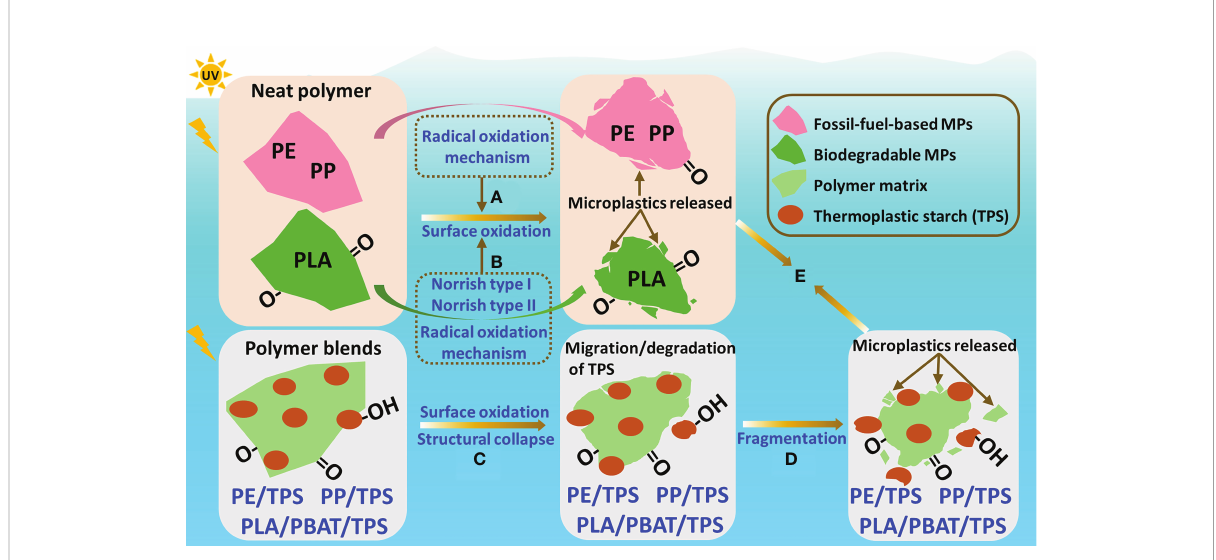
FIGURE 7 Schematic illustration of the possible photodegradation mechanisms of MPs. (A) Surface oxidation of PE and PP caused by free radical chain reactions; (B) surface oxidation of PLA caused by Norrish type I reaction, Norrish type II reaction, and radical oxidation reaction; (C) the island- sea structure of polymer blends collapses following surface oxidation; (D) fragmentation of polymer matrix; and (E) release of microplastics. Neat polymers: PE, PP, and PLA; polymer blends: PE/TPS, PP/TPS, and PLA/PBAT/TPS. PE, polyethylene; PP, polypropylene; PLA, polylactic acid; PE/TPS, polyethylene/thermoplastic starch blends; PP/TPS, polypropylene/thermoplastic starch blends; and PLA/PBAT/TPS, polylactic acid/poly (butylene adipate- co -terephthalate)/thermoplastic starch